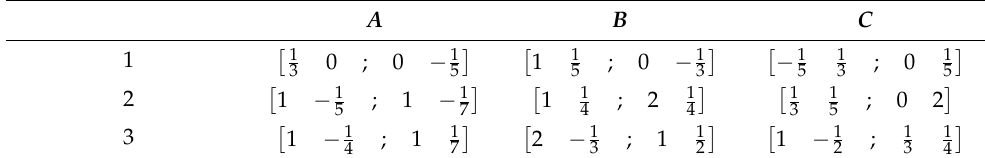
Table 1. Three sets of values of real system parameters in stochastic system [ A , B , C | d ] . A B C